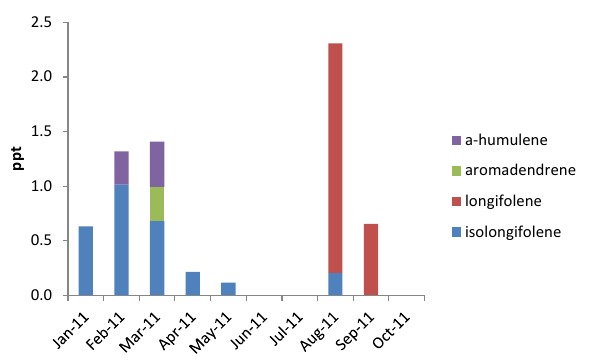
Fig. 3. The monthly mean mixing ratios of different sesquiterpene species at Hyyti¨al¨a. June and July measurements are missing due to chromatographic problems.